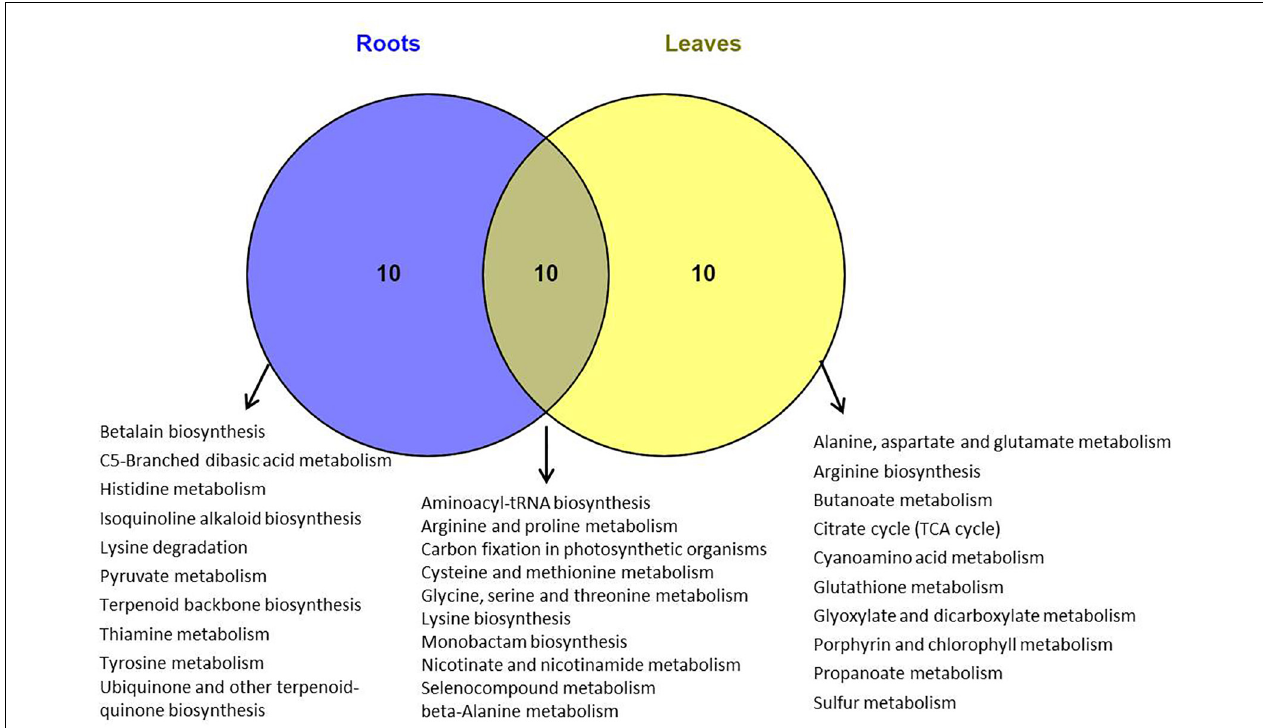
FIGURE 10 | Venn diagram of KEGG pathways in which differentially metabolites were involved in roots and leaves of Puccinellia nuttalliana plants treated with 150 mM NaCl for 6 days.